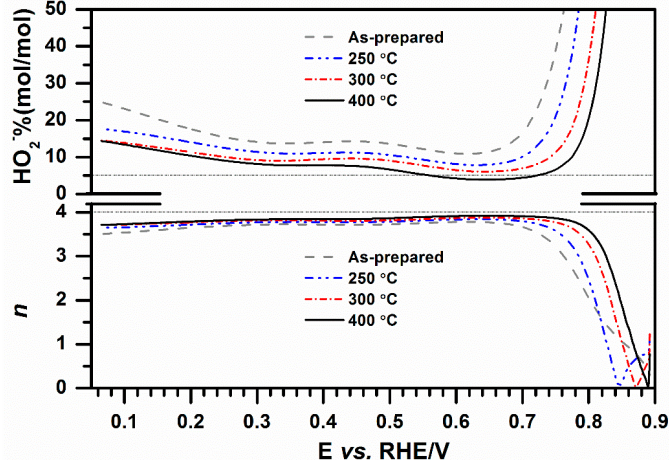
Figure 6. Molar fraction of HO 2 − formation and electron transfer number n at different potentials calculated from rotating ring-disk electrode (RRDE) curves in Figure